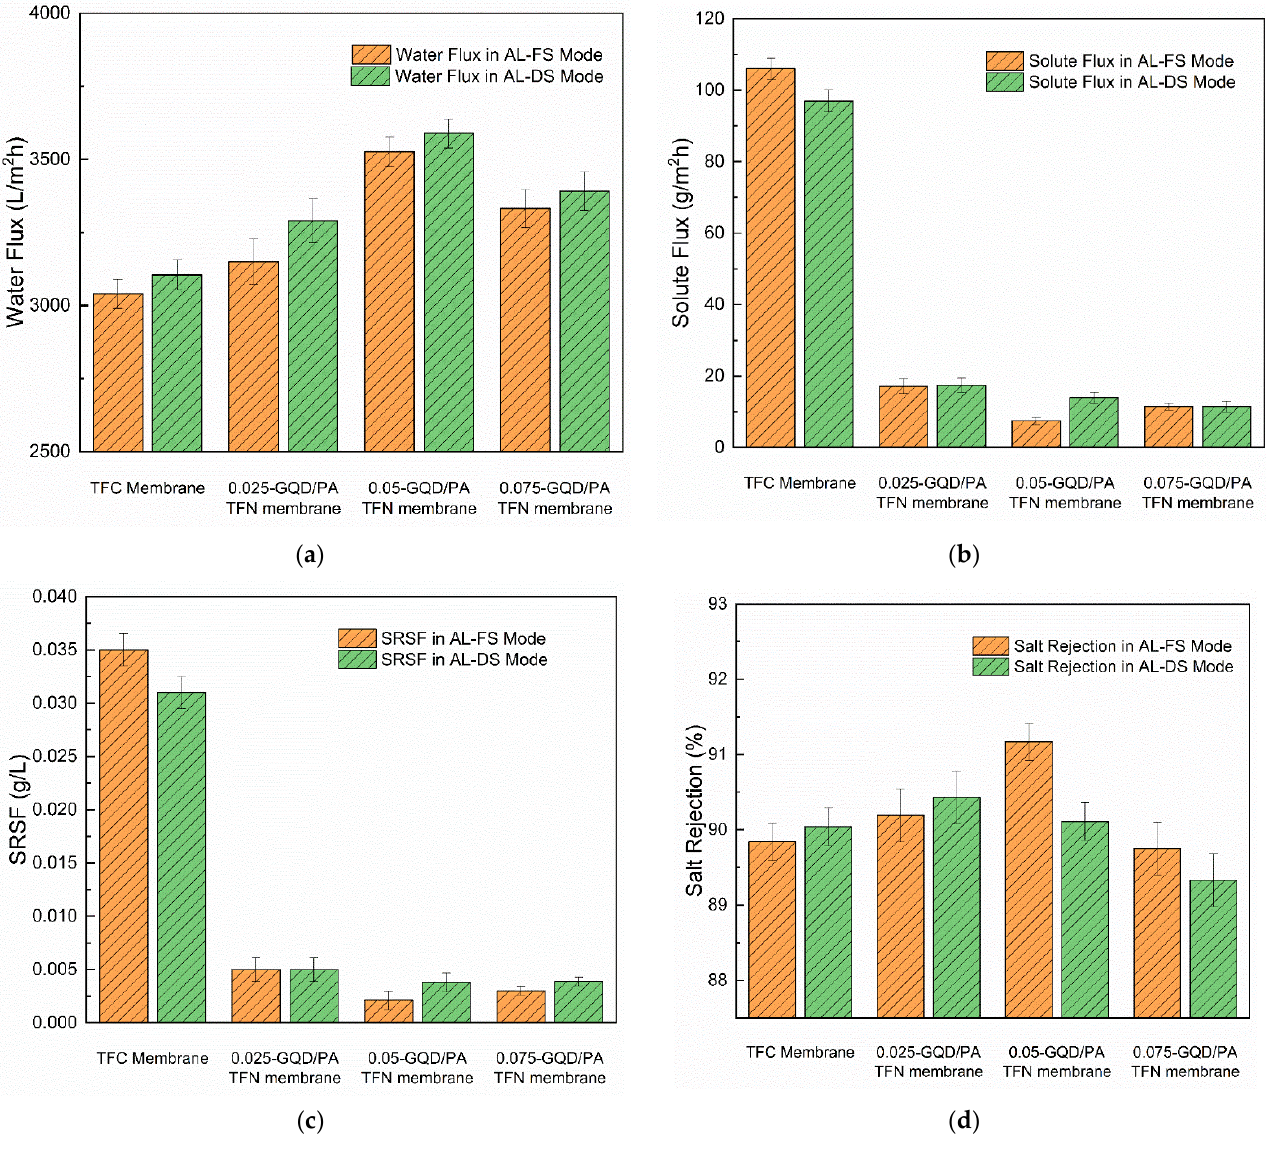
Figure 11. The impact of different concentrations of GQDs on the performance of TFC and TFN membranes. ( a ) Water flux of the developed membranes in AL-FS and AL-DS modes, ( b ) solute flux of the developed membranes in AL-FS and AL-DS modes, ( c ) specific reverse solute flux of the developed membranes in AL-FS and AL-DS modes, ( d ) salt rejection of the developed membranes in AL-FS and AL-DS modes.